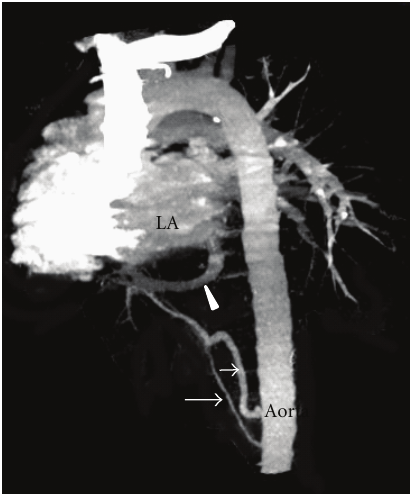
Figure 5: CT angiography volume rendered image depicts two anomalous arterial supply to the sequestration (arrows) and mean- dering right inferior pulmonary vein (arrow head).